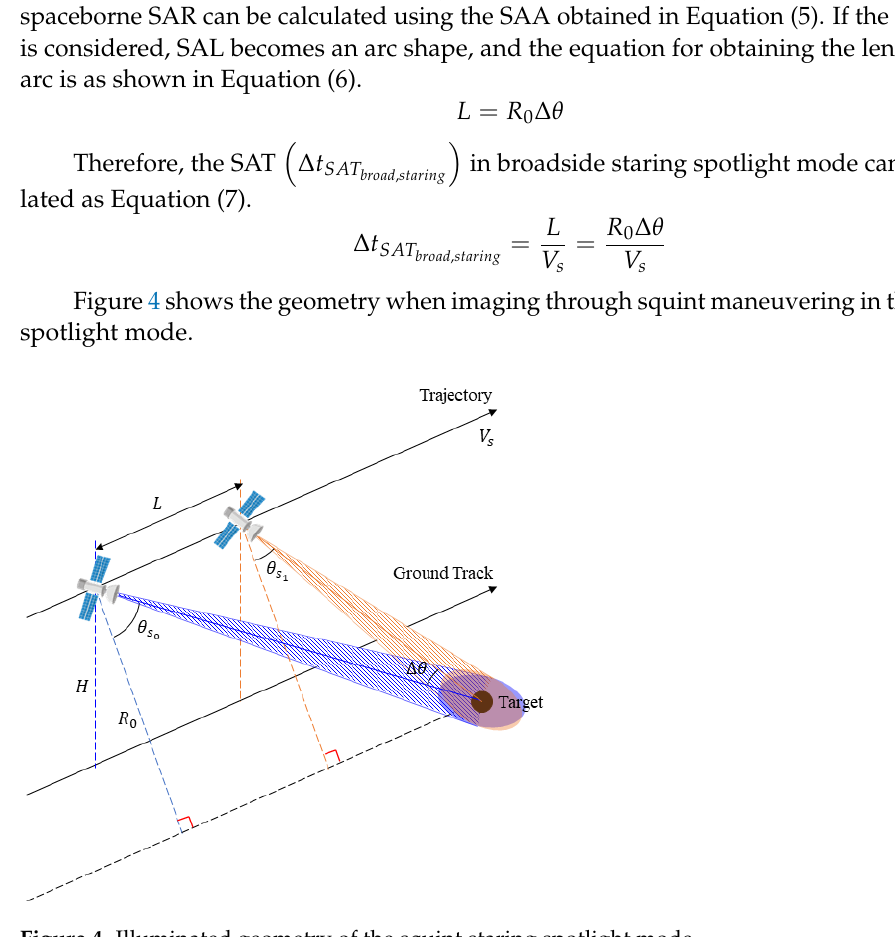
Figure 4. Illuminated geometry of the squint staring spotlight